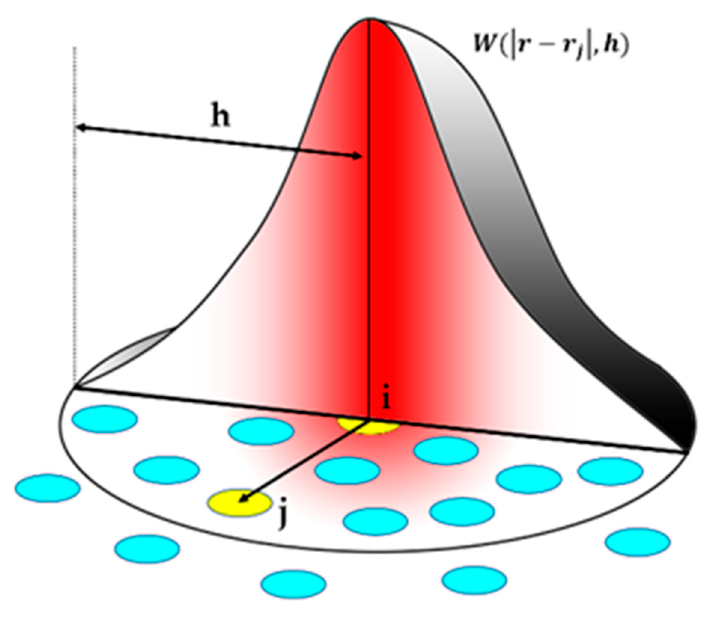
Figure 1. The smoothing kernel used by SPH obtains the weighted sum of the physical values within the kernel range.